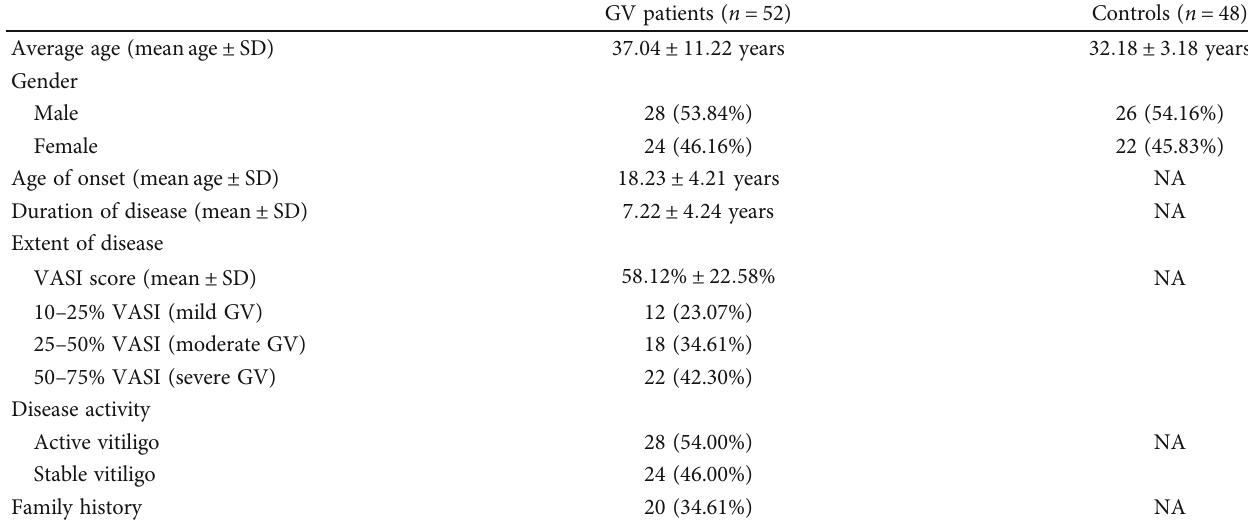
Table 1: Demographic characteristics of generalized vitiligo (GV) patients and